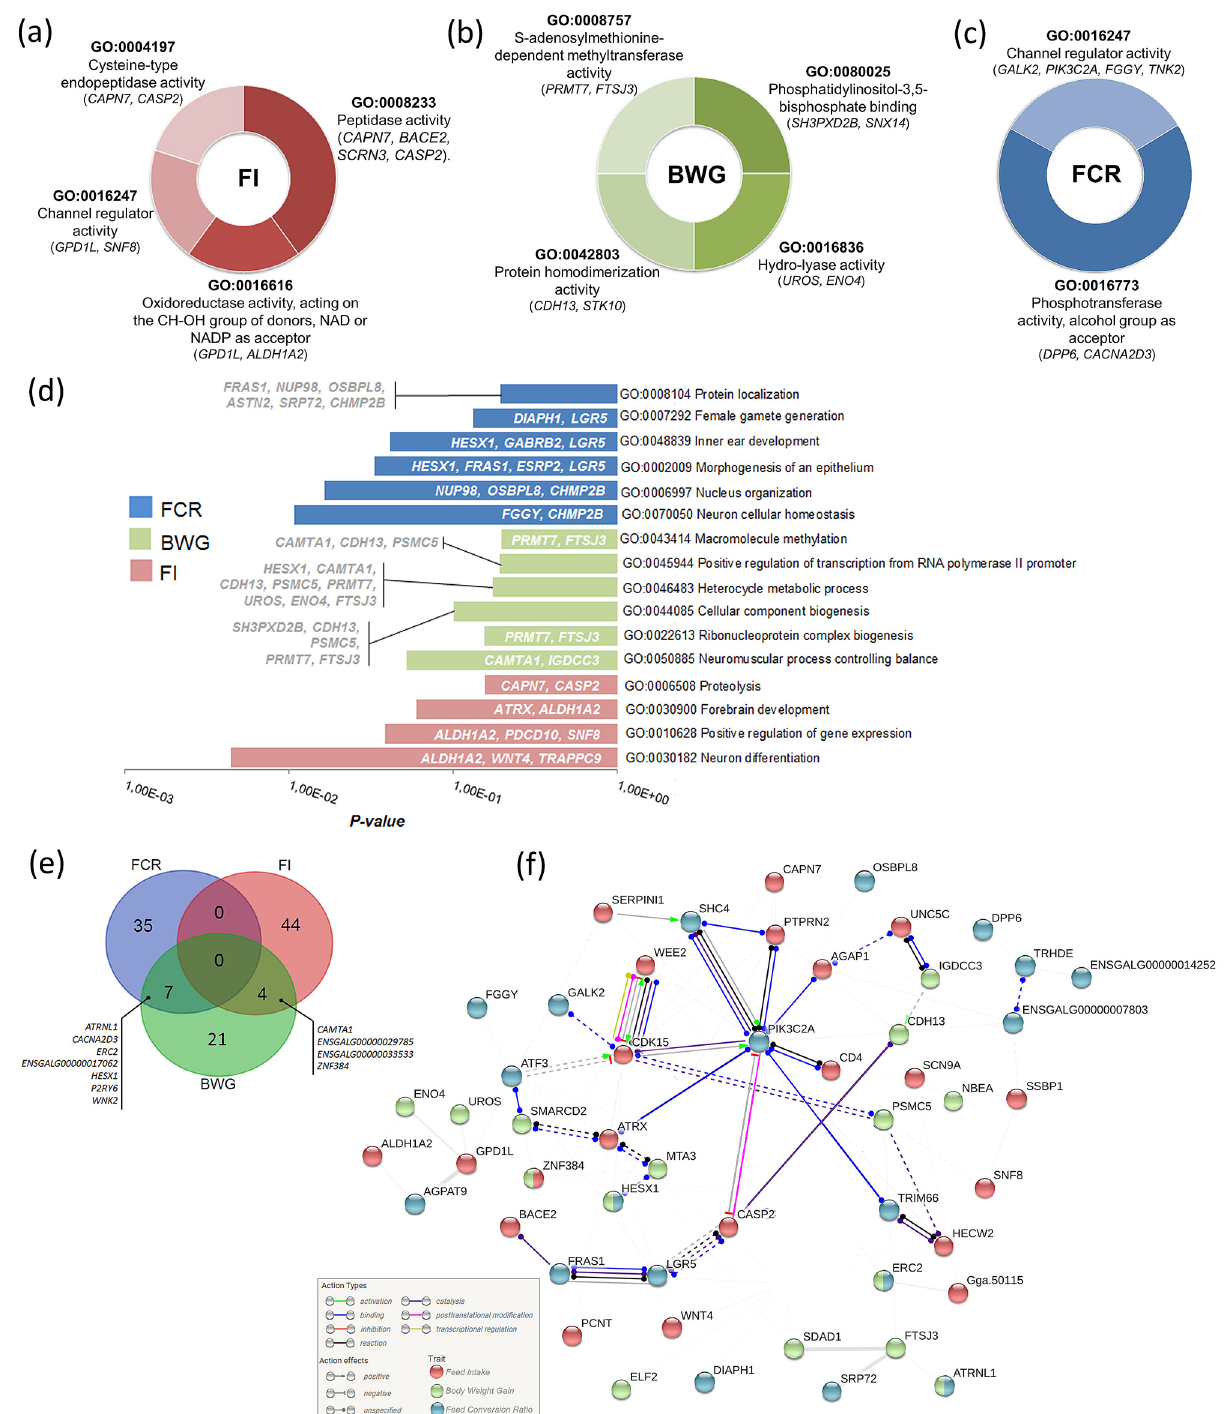
Figure 2. Enrichment analysis and gene networks for the candidate genes identified as associated with feed efficiency (FE) traits. Gene ontology (GO) analysis for terms of ( a – c ) molecular function and ( d ) biological processes; ( e ) Venn diagram summarizing the candidate genes found for the FE traits; ( f ) analysis of gene networks of candidate genes identified for feed intake (red nodes), body weight gain (green nodes) and feed conversion ratio (blue nodes). The gene network was constructed using STRING v10 62